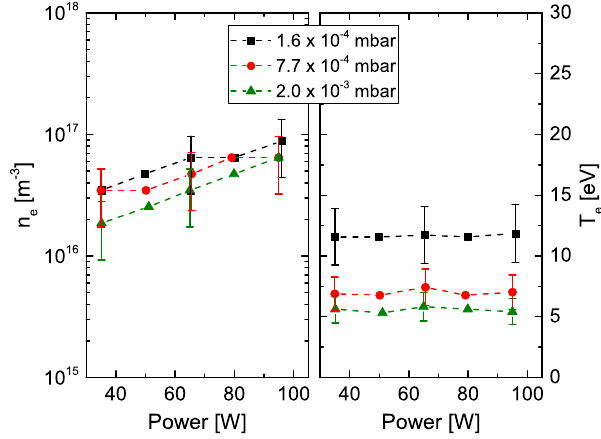
FIG. 5. Electron densities and temperatures obtained from the OES evaluations for varying power at different pressures and ¼ 0 . 56 . =B fixed ratio B min ECR